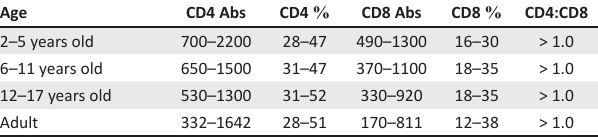
Source : Shearer WT, Rosenblatt HM, Gelman RS, et al. Pediatric AIDS Clinical Trials Group. Lymphocyte subsets in healthy children from birth through 18 years of age: The Pediatric abs, absolute.